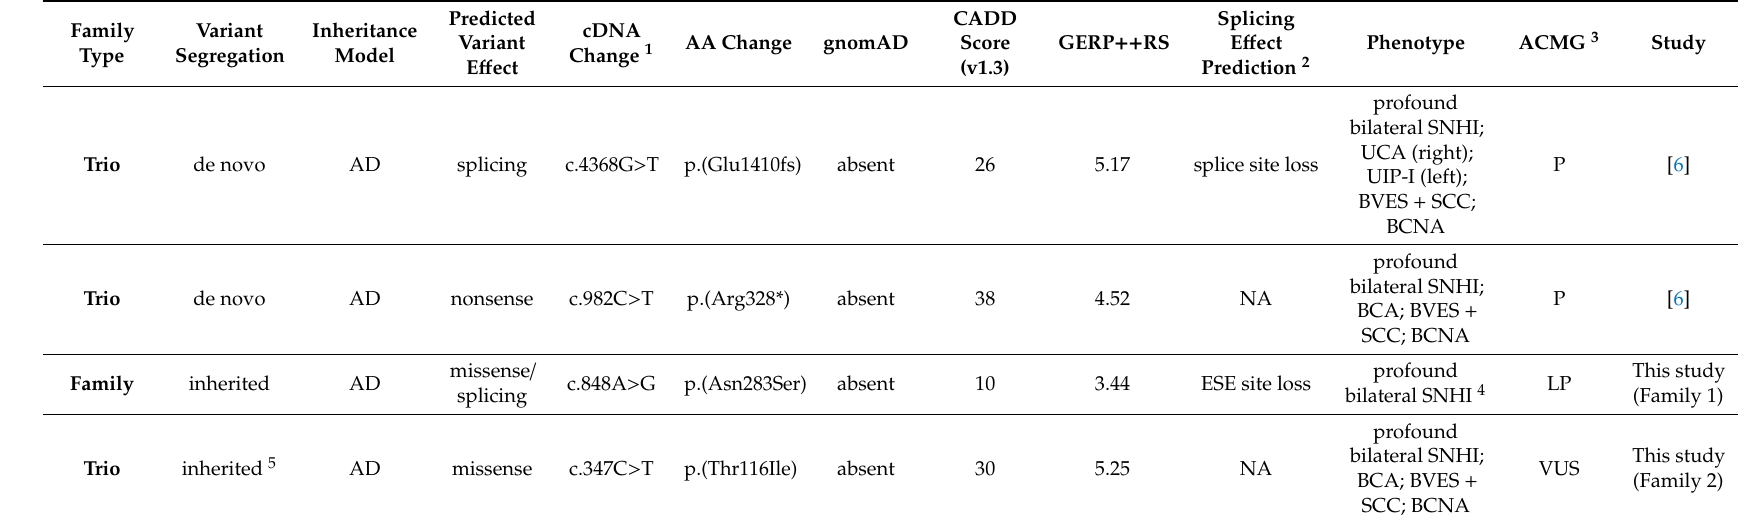
Table 1. Variants identified in GREB1L associated with nonsyndromic hearing